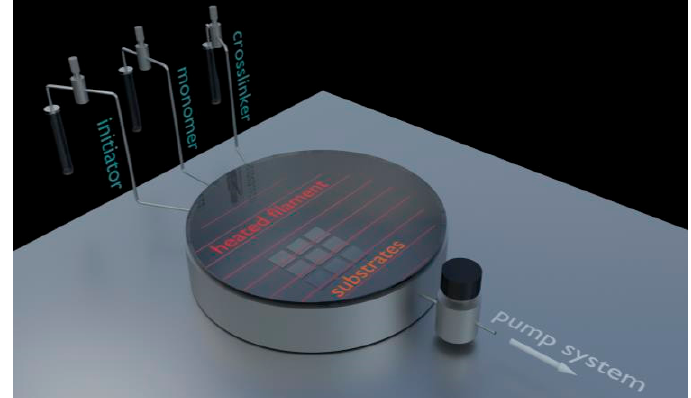
Figure 1. Scheme of the setup used for the initiated Chemical Vapor Deposition (iCVD)